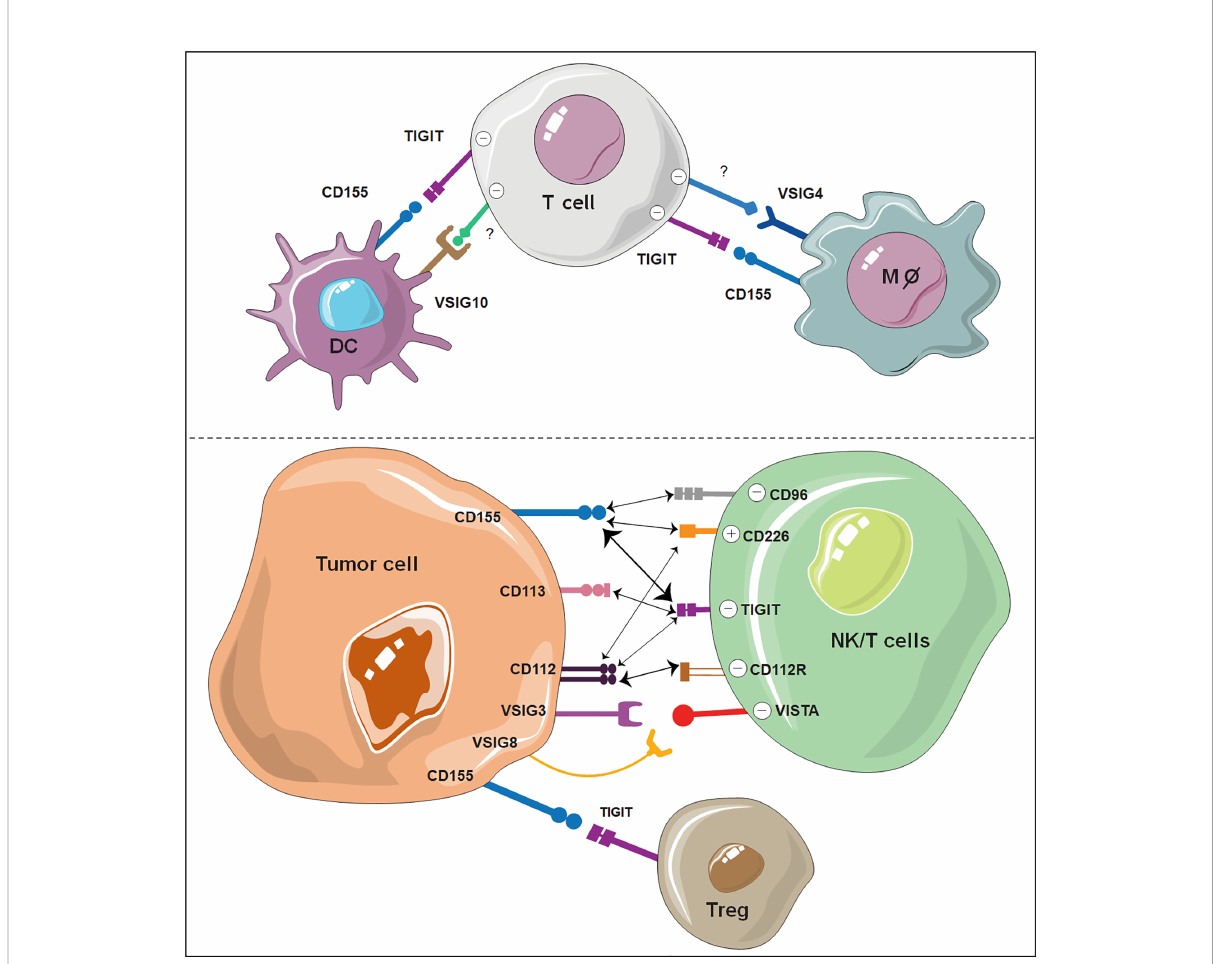
FIGURE 2 Illustration of VSIG family members as potential ICBs on immune cells. The interaction of TIGIT, VSIG3, VSIG8 and VSIG4 with other ligand- expressing cells shows great potential as novel immune checkpoints. VSIG10 also shows potential as a coinhibitory receptor on DCs. The width of the arrows is proportional to the relative binding af fi nities. The strongest interactions are between TIGIT/CD155 and CD112R/CD112. Negative (-) represents an inhibitory signal, and positive (+) represents an activating